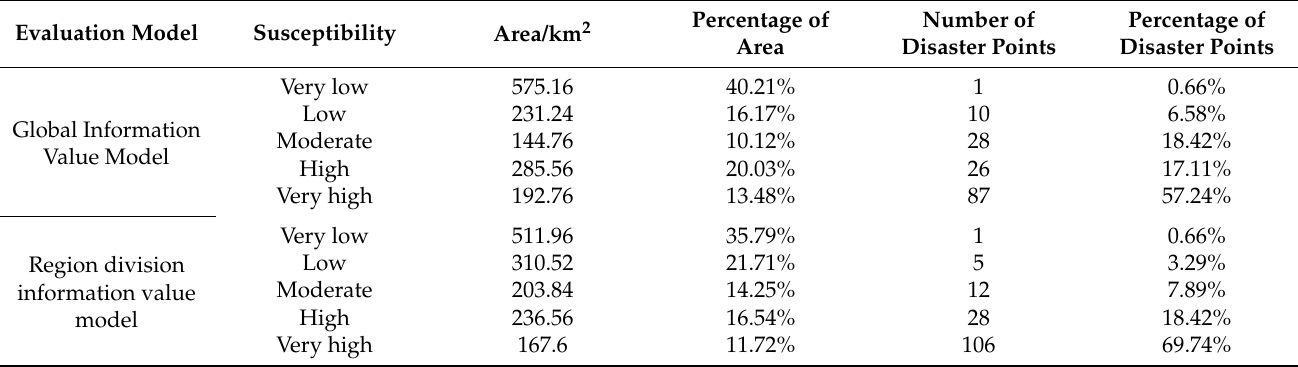
Table 5. Result statistics of the susceptibility evaluation.